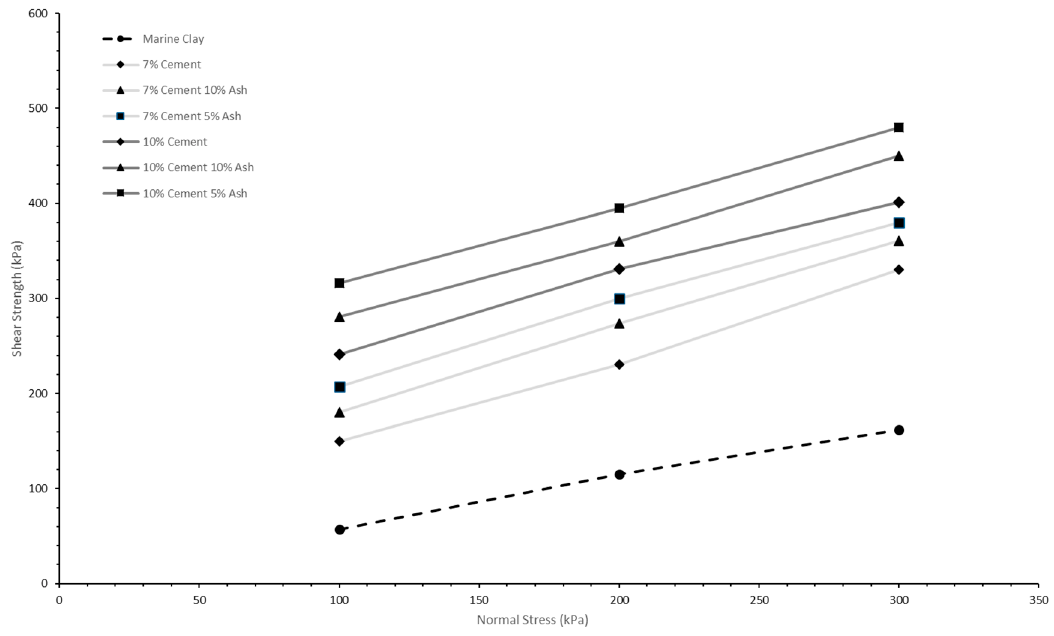
Figure 11. Variation in direct shear failure envelopes for blends considering marine clay, 7% cement, 10% cement, cement + 5% wood-ash, and cement + 10% wood-ash.